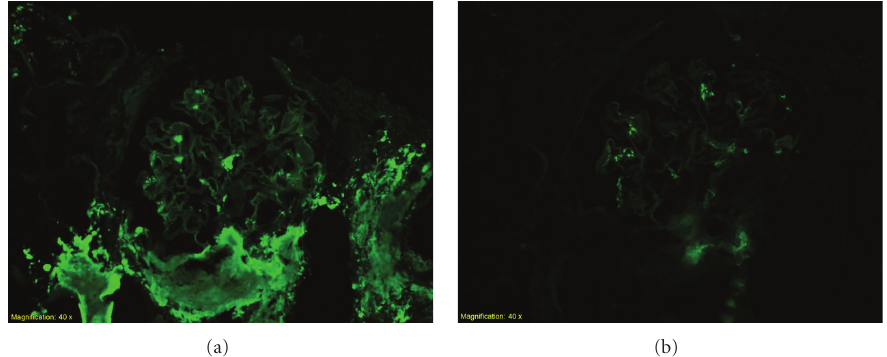
Figure 3: Immunofluoresence study showing reactivity of the amorphous eosinophilic material for kappa light chains predominantly in vessels, limited in glomerulusc (a), but not lambda light chains